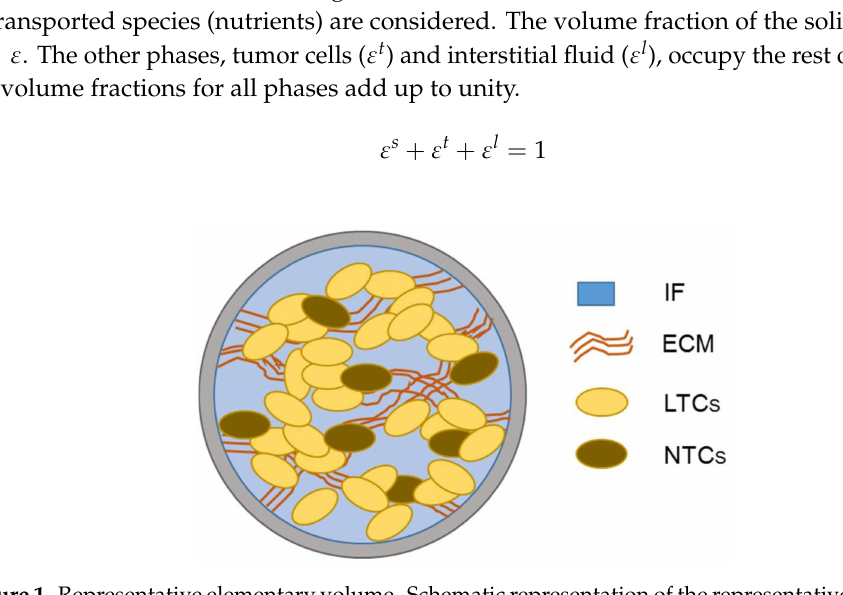
Figure 1. Representative elementary volume. Schematic representation of the representative elementary volume (REV) used in the simulations. This comprises the three phases of the problem: tumor cells (TCs), divided in living and necrotic ones, interstitial fluid (IF), and the extracellular matrix